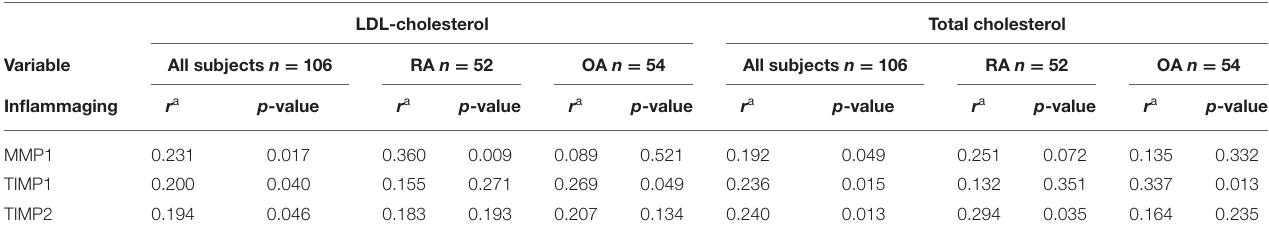
TABLE 7 | Significant correlations between lipid profile and inflammaging